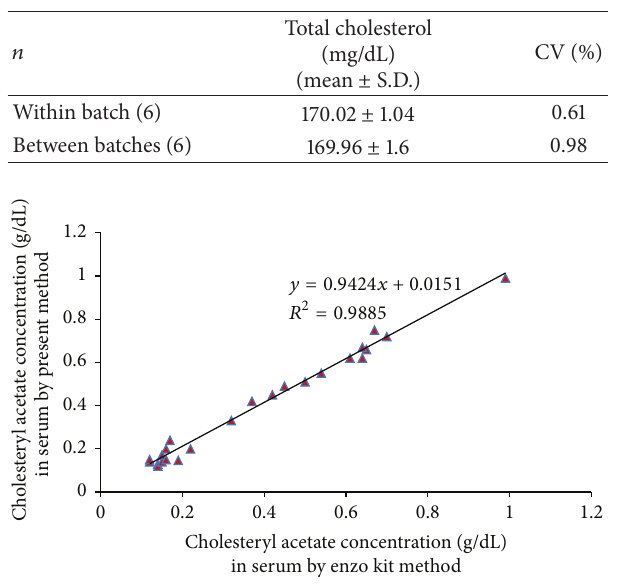
Figure 12: Correlation between cholesteryl acetate concentrations in serum determined by standard enzo kit method ( 𝑥 -axis) and by the present method ( 𝑦